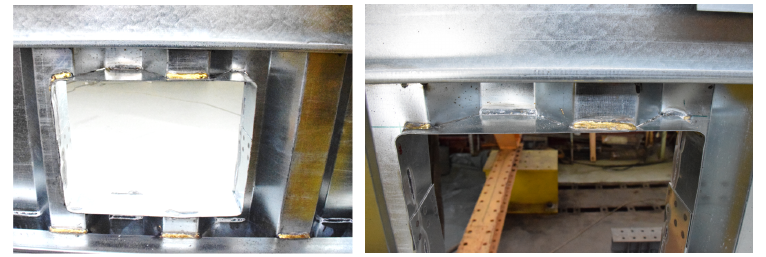
Figure 5. Reinforcement the web opening for the CWB-CMT-WO specimen assembled by MIG braz- ing.